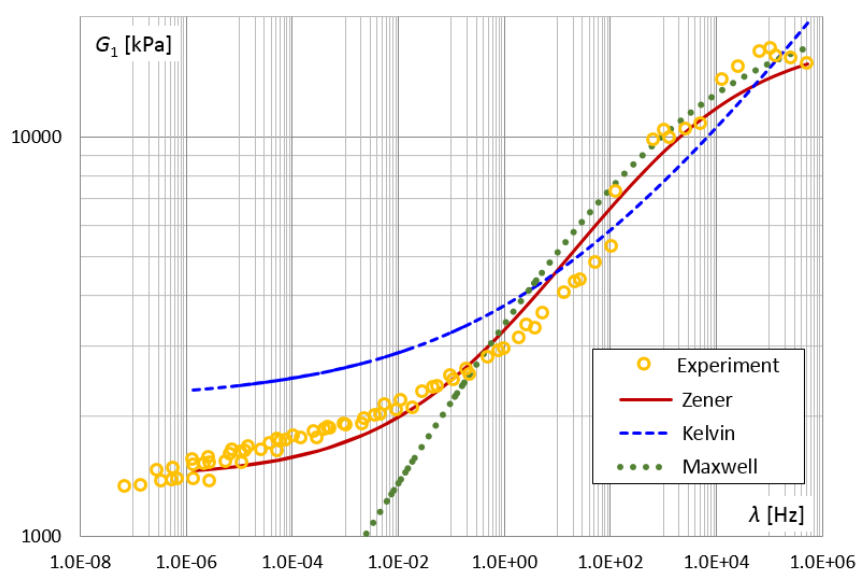
Figure 28. The shear storage modulus G 1 vs. frequency for different fractional models.